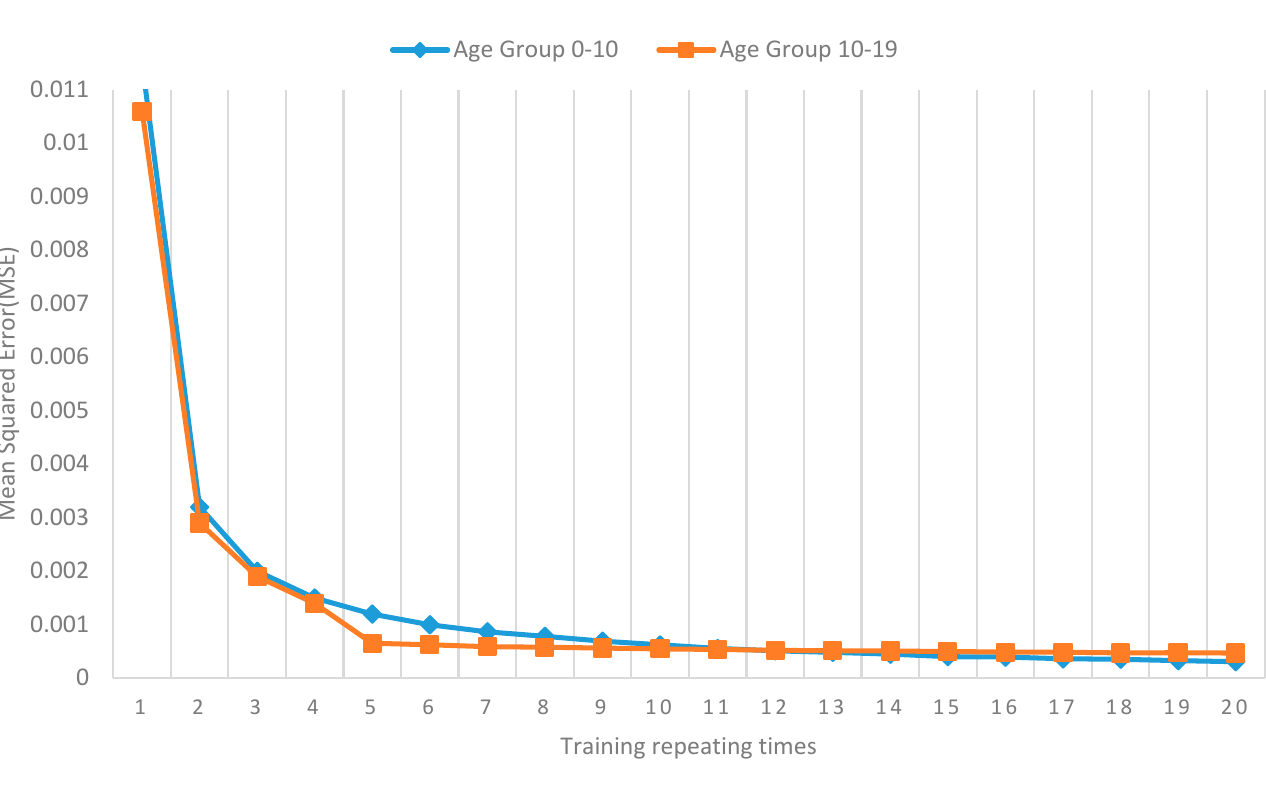
Figure 6. Mean Squared Error (MSE) for incremental batch learning method. The Mean Squared Error (MSE) represents the simulation error of the model for the age groups 0–9 and 10–19, while the training repetitions represent the number of repetitions of the training process used to determine the number of training iterations in the simulation model. Table 3. Results of model evaluation for groups 0–9 and